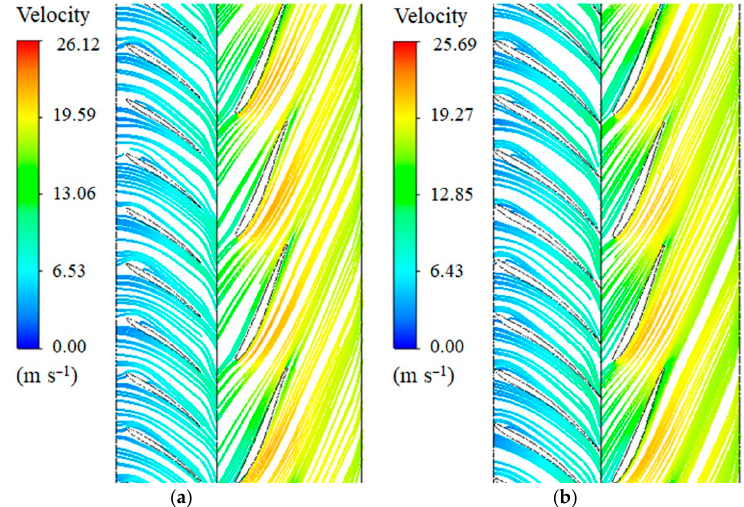
Figure 18. Vane-to-vane velocity streamline distribution of guide vanes and runner vanes: ( a ) at short chord; ( b ) at long chord.